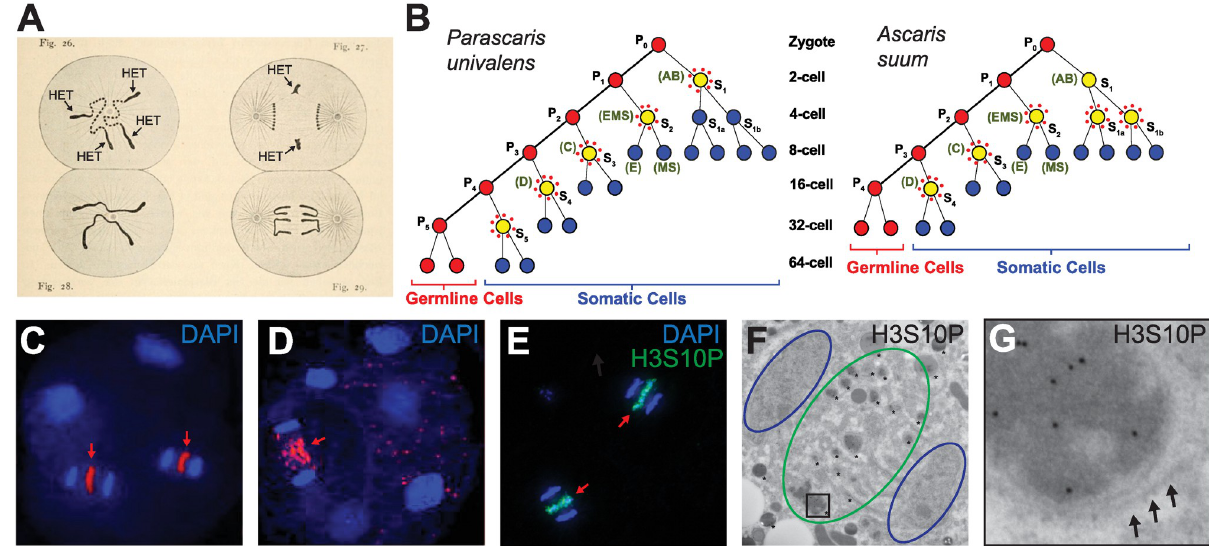
Fig 1. PDE occurs during nematode early embryogenesis. ( A ) Theodor Boveri’s drawing of P . univalens DNA elimination in a two-cell embryo. Left: interphase, chromosomes in the pre-somatic cell (top) are fragmented from PDE, while the chromosomes from the germ cell (bottom) are intact. Right: anaphase, the pre-somatic cell sequesters the chromosome fragments and leaves the HET arms at the metaphase plate. Image from Wikimedia commons. ( B ) P . univalens and Ascaris early cell lineage during early development. Germ cells are red, pre-somatic cells are yellow and surrounded by red dots, and somatic cells are blue. PDE occurs during successive divisions in early embryogenesis. Figure adapted from [37,38].( C ) A 4-cell Ascaris embryo with 2 cells undergoing PDE. DAPI staining showing eliminated DNA (artificially colored in red for emphasis) is left at the metaphase plate (red arrow) but retained DNA is segregated to the daughter nuclei. ( D ) A 6-cell Ascaris embryo with 1 cell undergoing PDE. Eliminated DNA begins to degrade during late anaphase (red arrow). Eliminated DNA fragments from previous PDE events are seen scattered across the embryo. Images in ( C ) and ( D ) are from [36]. ( E) DAPI and H3S10P immuno-staining of Ascaris PDE. Eliminated DNA at the metaphase plate (red arrow) is stained with an antibody against H3S10P. ( F ) H3S10P Immuno-EM shows double-membrane bound H3S10P-positive structures between daughter nuclei during telophase of Ascaris PDE. Daughter nuclei are circled in blue. The region containing eliminated DNA is circled in green (for comparison with ( E )). Double-membrane structures positive for H3S10P are marked with an asterisk ( � ). ( G ) Inset from ( F ). Arrows point to double-membrane structure. ( E ) and ( F ) are adapted from